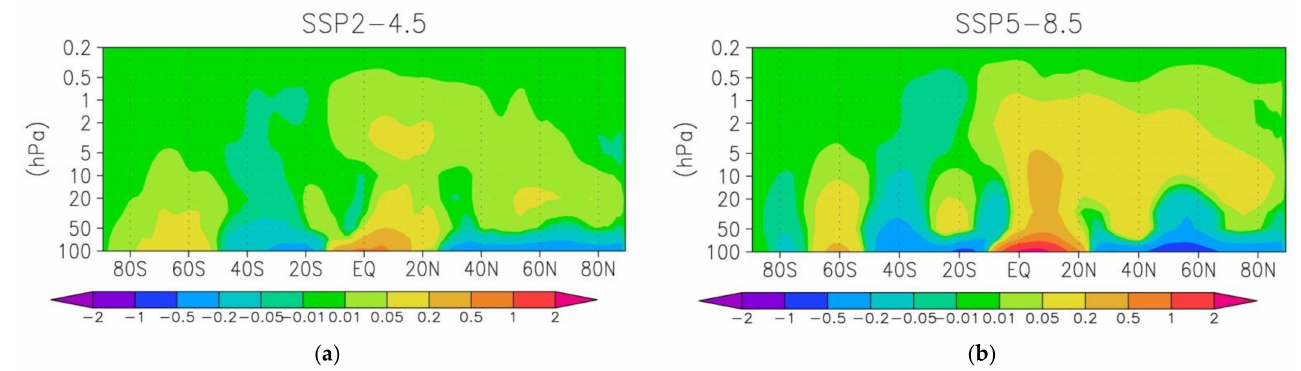
Figure 6. Change in the residual stream function [kg/s 10 9 ] averaged over December–February between two periods 2081–2100 and 2016–2035 in the moderate ( a ) and severe scenario ( b ).